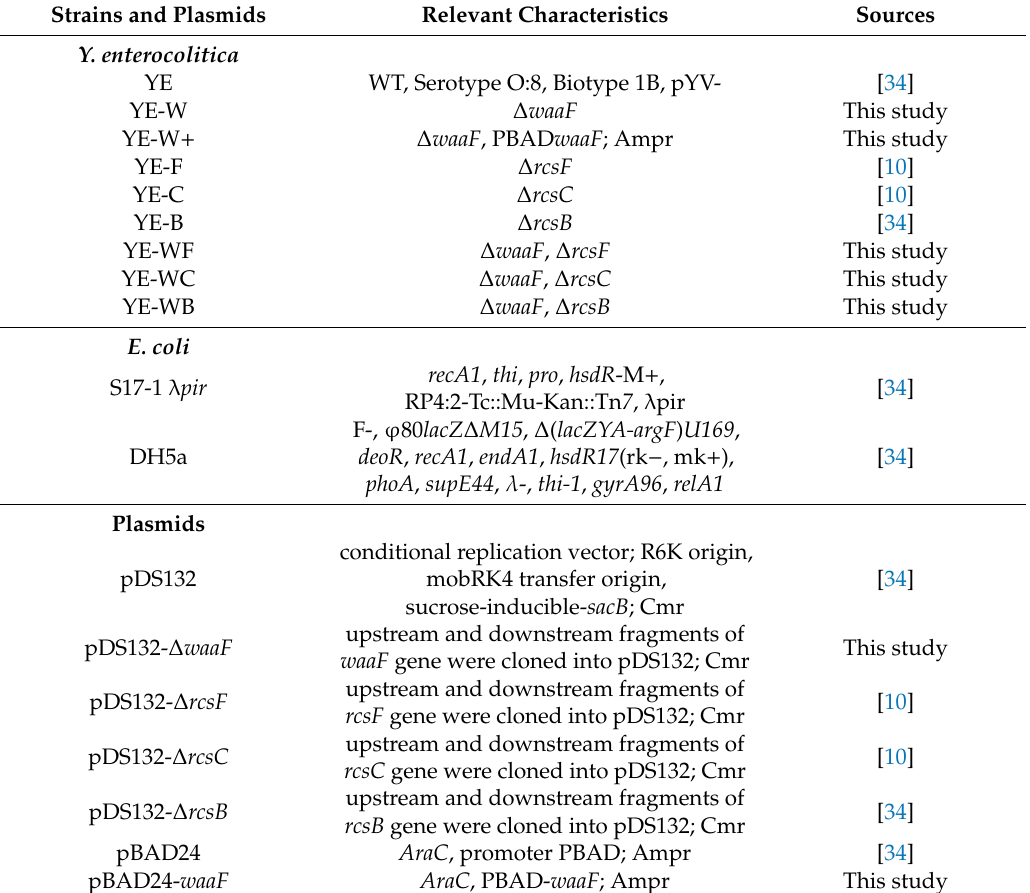
Table 1. Bacterial strains and plasmids used in this